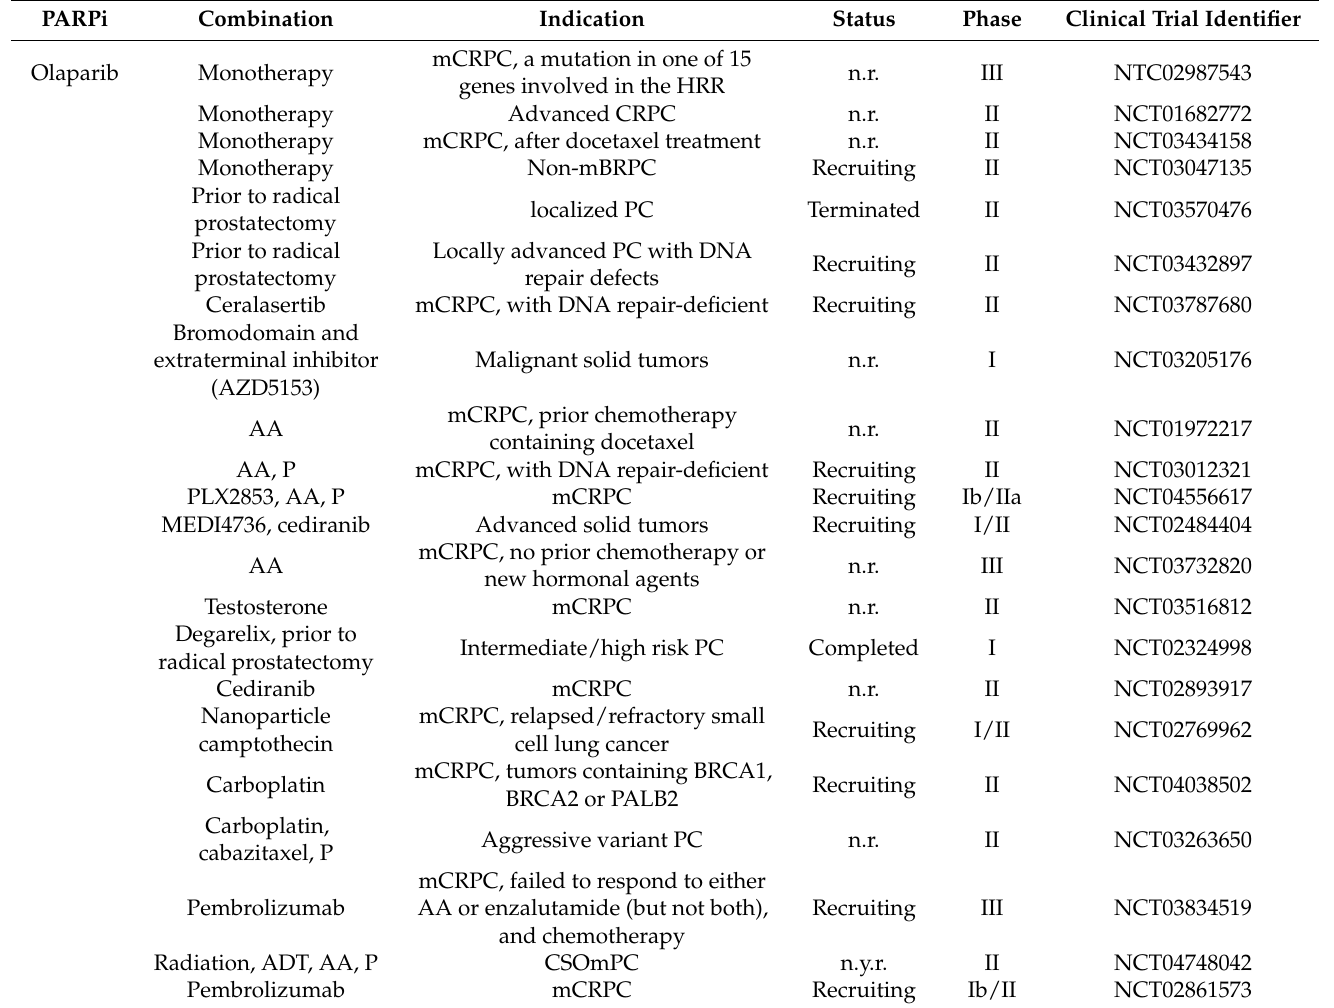
Table 1. A summary of ongoing or completed clinical trials using poly(ADP-ribose) polymerase (PARPi) in prostate cancer treatment, registered to April 2021 in ref.